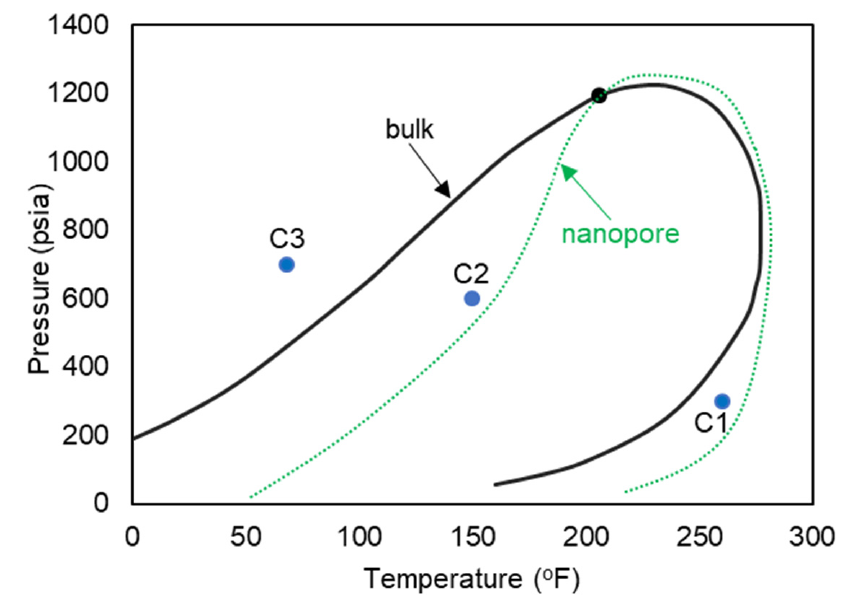
Figure 10. Pressure-temperature diagram of the ethane–heptane mixture. The three pressure and temperature conditions are shown with C1 (a gas phase in bulk), C2 (a two-phase in bulk), and C3 (a liquid phase in bulk) on the pressure–temperature diagram of Figure 10. The anticipated shifted phase envelope in the nanopore-confined space is also shown schematically on the phase diagram of Figure